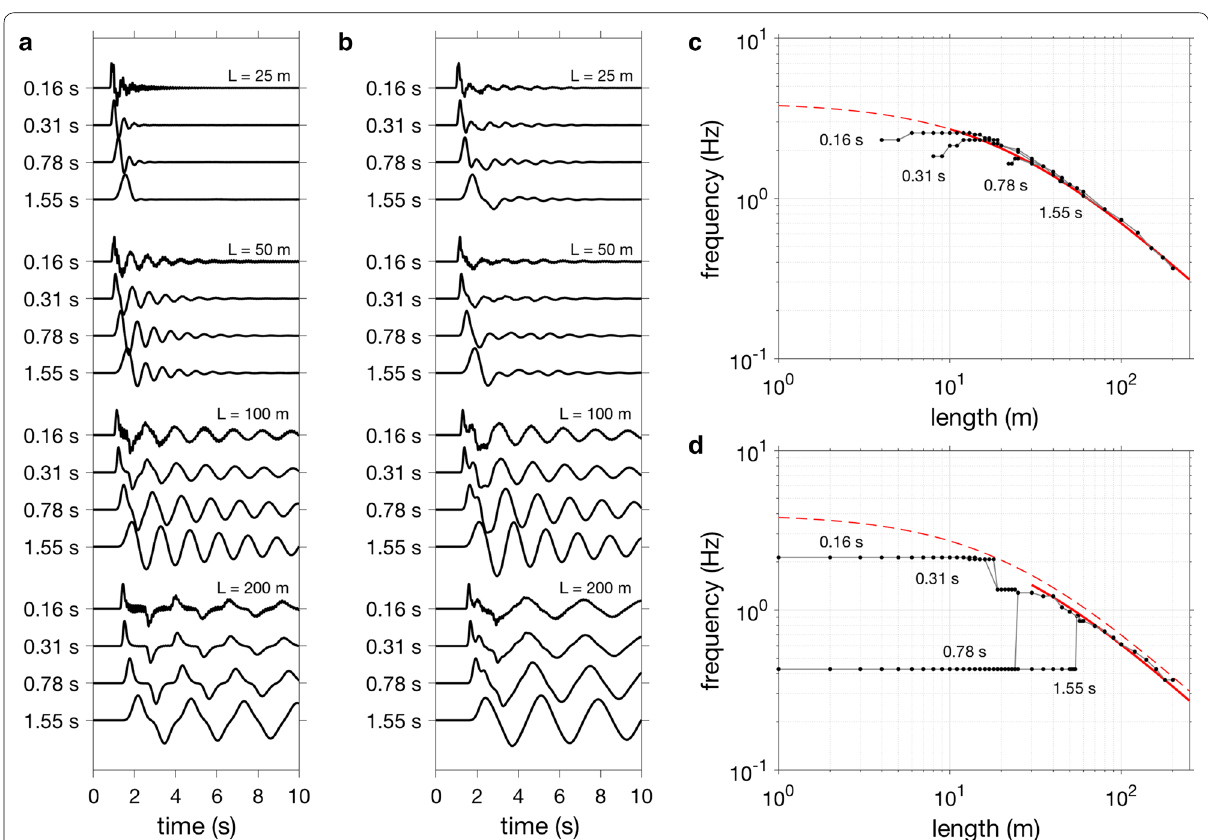
Fig. 9 Results of FDTD numerical calculation. a Simulated waveforms to be observed at ACM without consideration of topography (see Fig. 8b–f). The results obtained using four different pulse widths of the source (Fig. 8a) and four conduit lengths are shown. Radius of the conduit is fixed as 25 m for all cases. b Simulated waveforms of the FDTD calculation including the topographic data of Aso volcano. c The peak frequency of the 10-s synthetic waveforms as shown in a for the no-topography calculation. The observed frequencies for the > 10m conduit lengths are fit to theoretical values estimated using Eq. (3) (red line). d The frequencies of the waveforms in b using the Aso DEM are 15% smaller (red line; > 30m length) than the theoretical expectation at a simple pipe with a flat topography (broken red line; same line in c